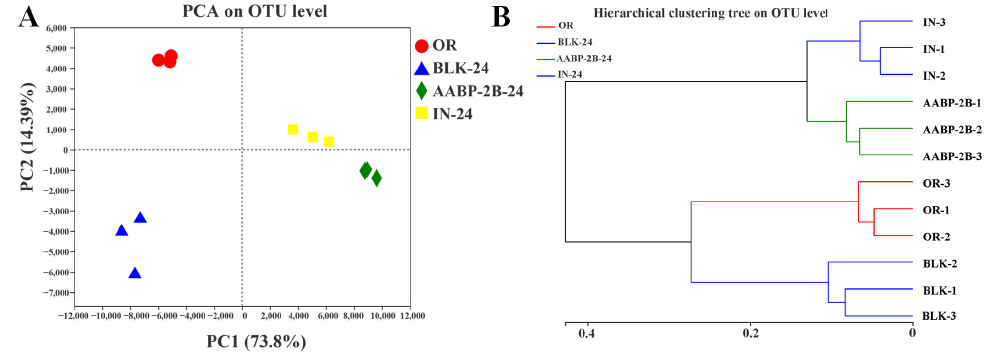
Figure 8. OTU-level PCA of gut microbiota; ( A ) hierarchical clustering tree on OUT level ( B ).